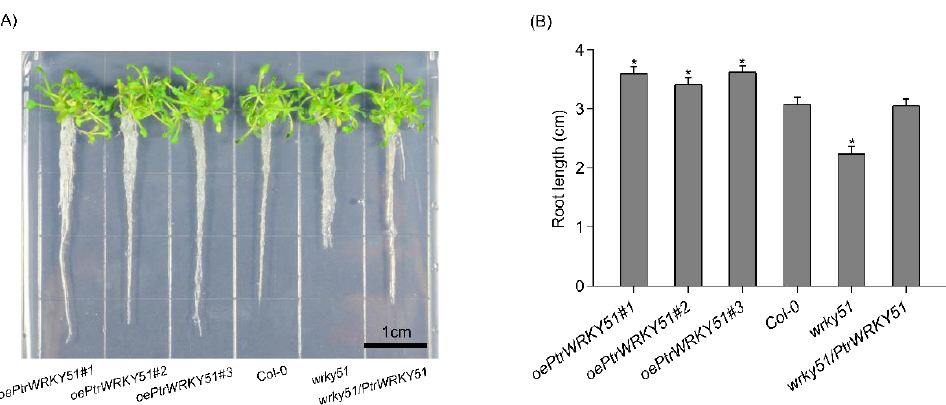
Figure 3. Root length analysis of overexpressing PtrWRKY51 in plants under normal conditions. ( A ) Phenotypic analysis of the primary root length for 10 days on 1/2MS medium. Bars, 1 cm. ( B ) Difference in the primary root length after 10 days of vertical growth on 1/2MS medium. The data are represented as means ± SE ( n = 12). The asterisks (*) represent significant differences (* p < 0.05) compared to the control.